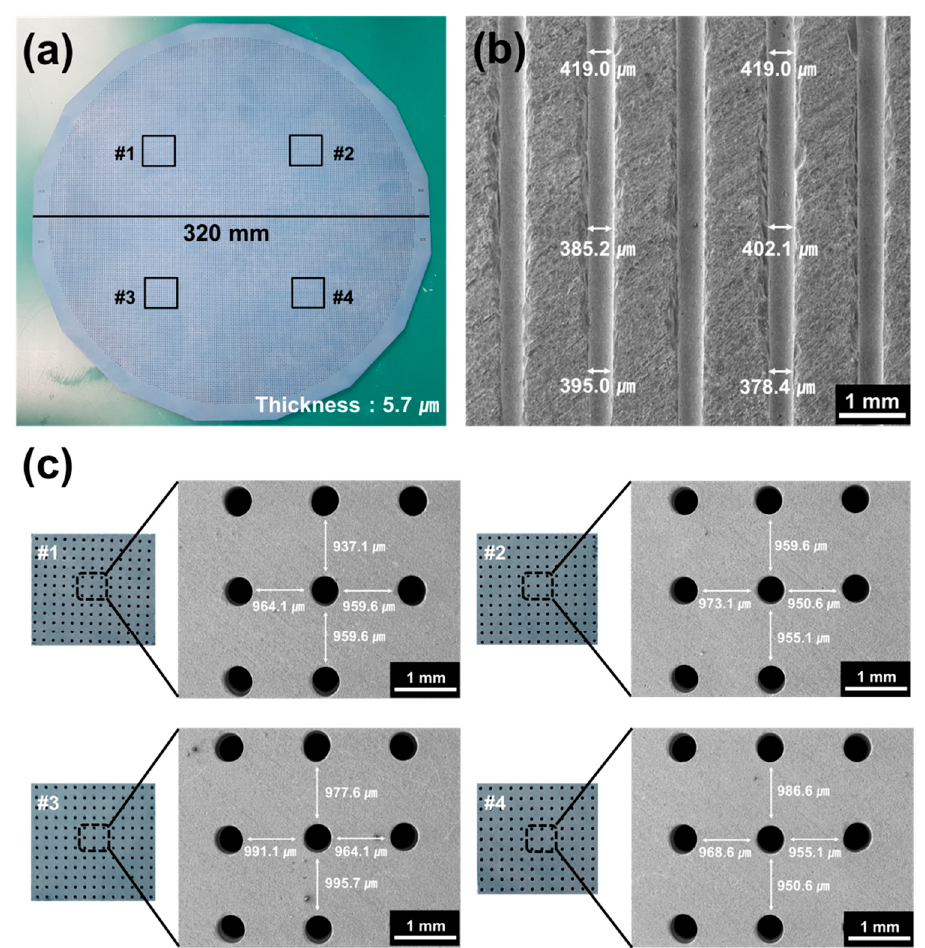
Figure 7. The ceramic substrate fabricated by using mullite–cordierite composite containing 70 wt% mullite–30 wt% cordierite sintered at 1350 °C: ( a ) large-area ceramic composite substrate, ( b ) cross- mullite–30 wt% cordierite sintered at 1350 ◦ C: ( a ) large-area ceramic composite substrate, ( b )